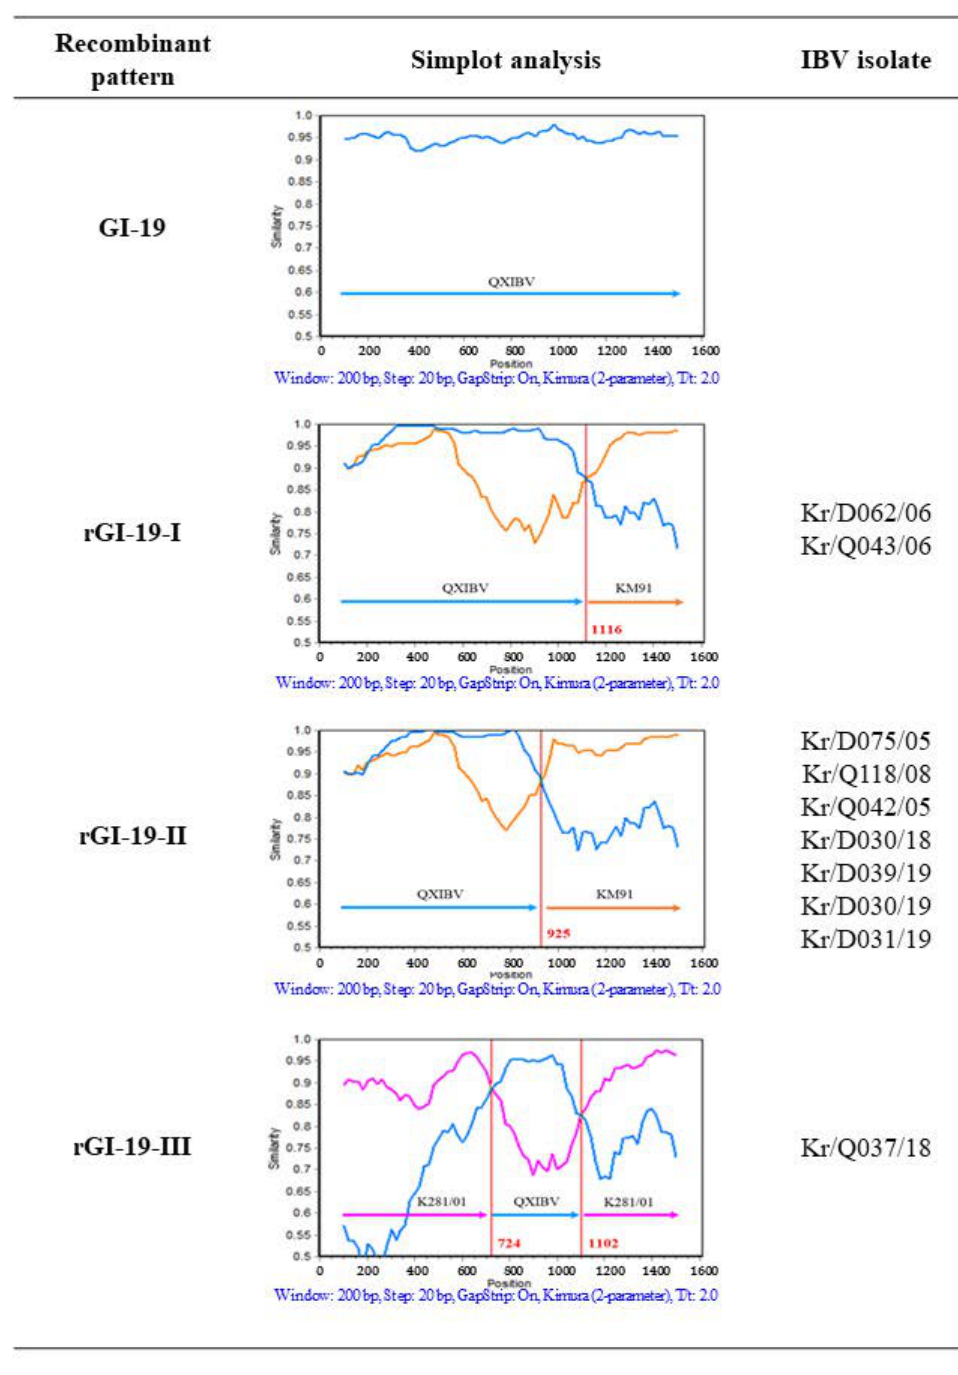
Figure 3. Recombination analysis in the S1 gene of ten IBV isolates and their putative parents (QXIBV (blue), KM91 (orange), and K281/01 (pink)). The y -axis shows the percentage identity within a sliding window that is 200 bp wide and centered on the position plotted, with a step size between plots of 20 bp. The red vertical line denotes the recombination